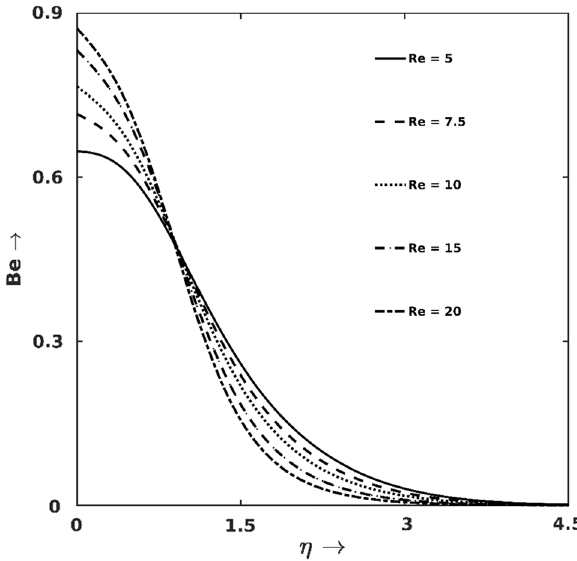
Figure 8. Re effect on Be .